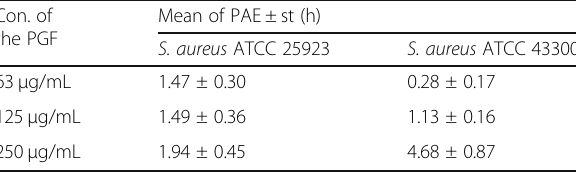
Table 4 Postantibiotic effects of the PGF Con. of the